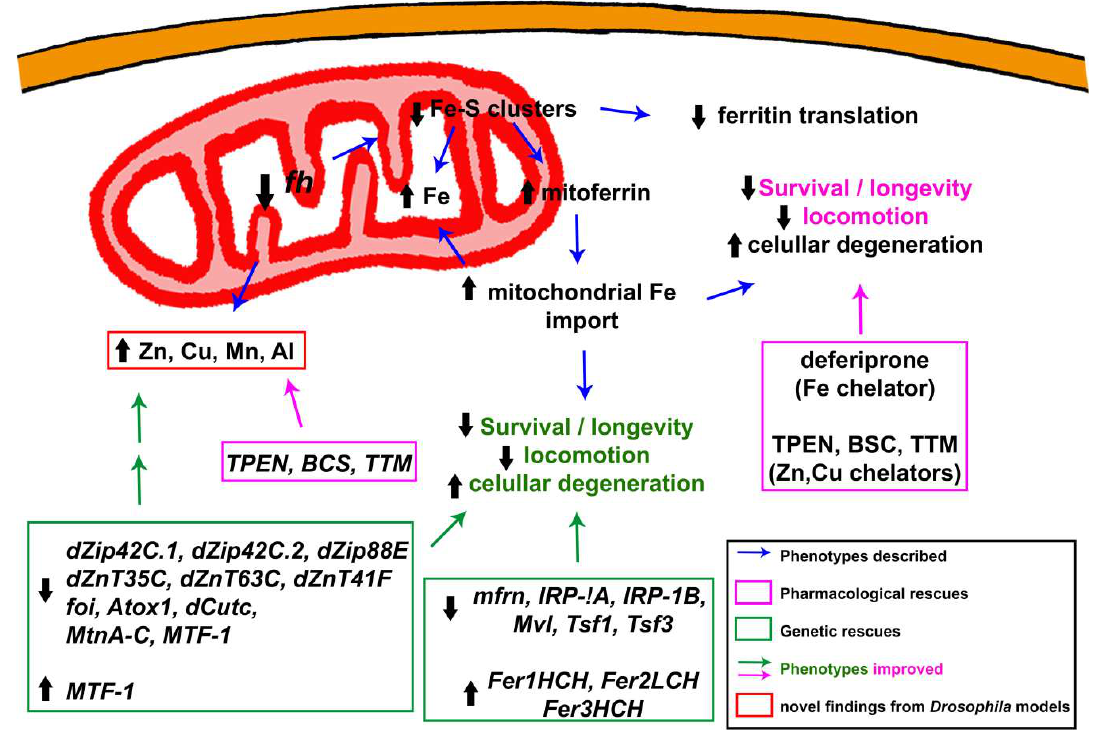
Figure 2. Graphic summary of molecular defects and rescues described in Drosophila melanogaster models of frataxin-deficiency in relation to iron metabolism and homeostasis of other metals.